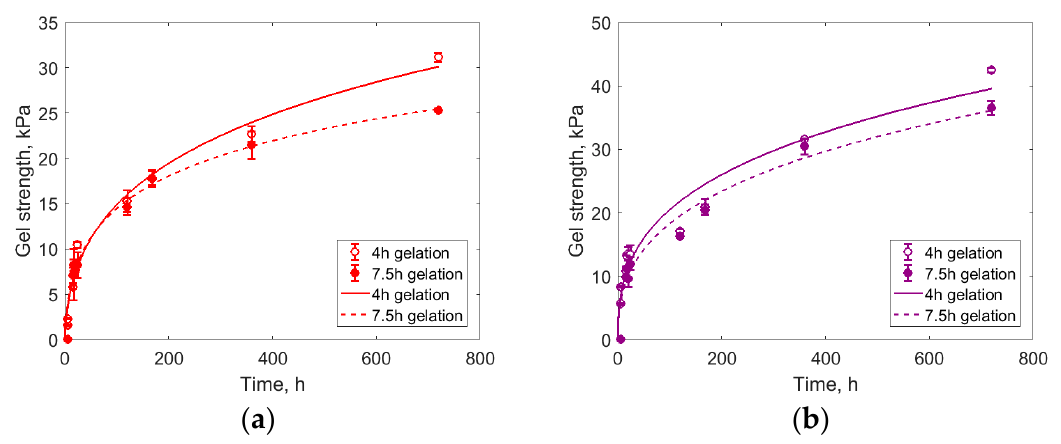
Figure 5. ( a ) Silica gelation without additives; ( b ) Silica gelation with 0.05% Praestol 2540 added. Gelation times were adjusted by sodium citrate dosage. Lines are Gompertz model fits.